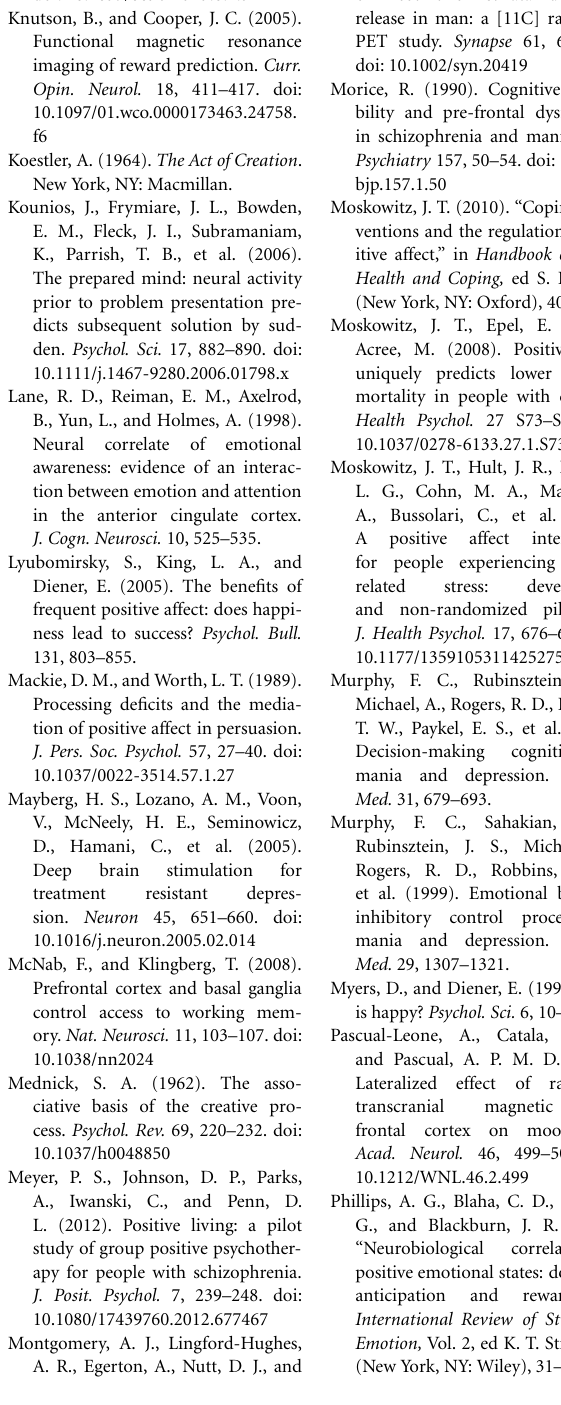
repetition paradigm: enhancement of novel metaphors and suppres- sion of conventional metaphors in the left inferior parietal